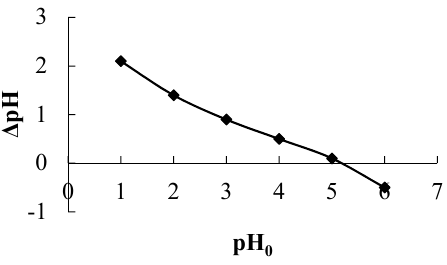
Figure 5. Zero point of charge (PZC) of scoria.